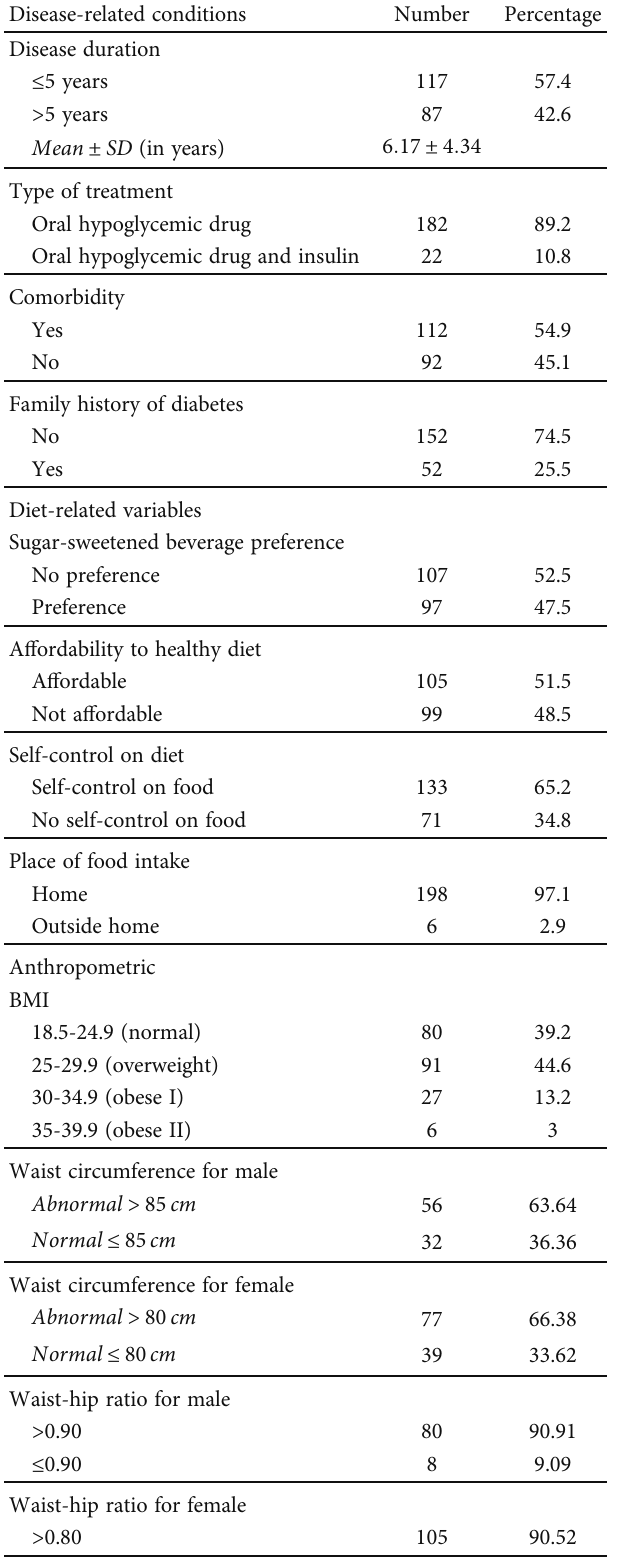
Table 2: Distribution of participants by disease-related, dietary factors, medication adherence, and anthropometric-related